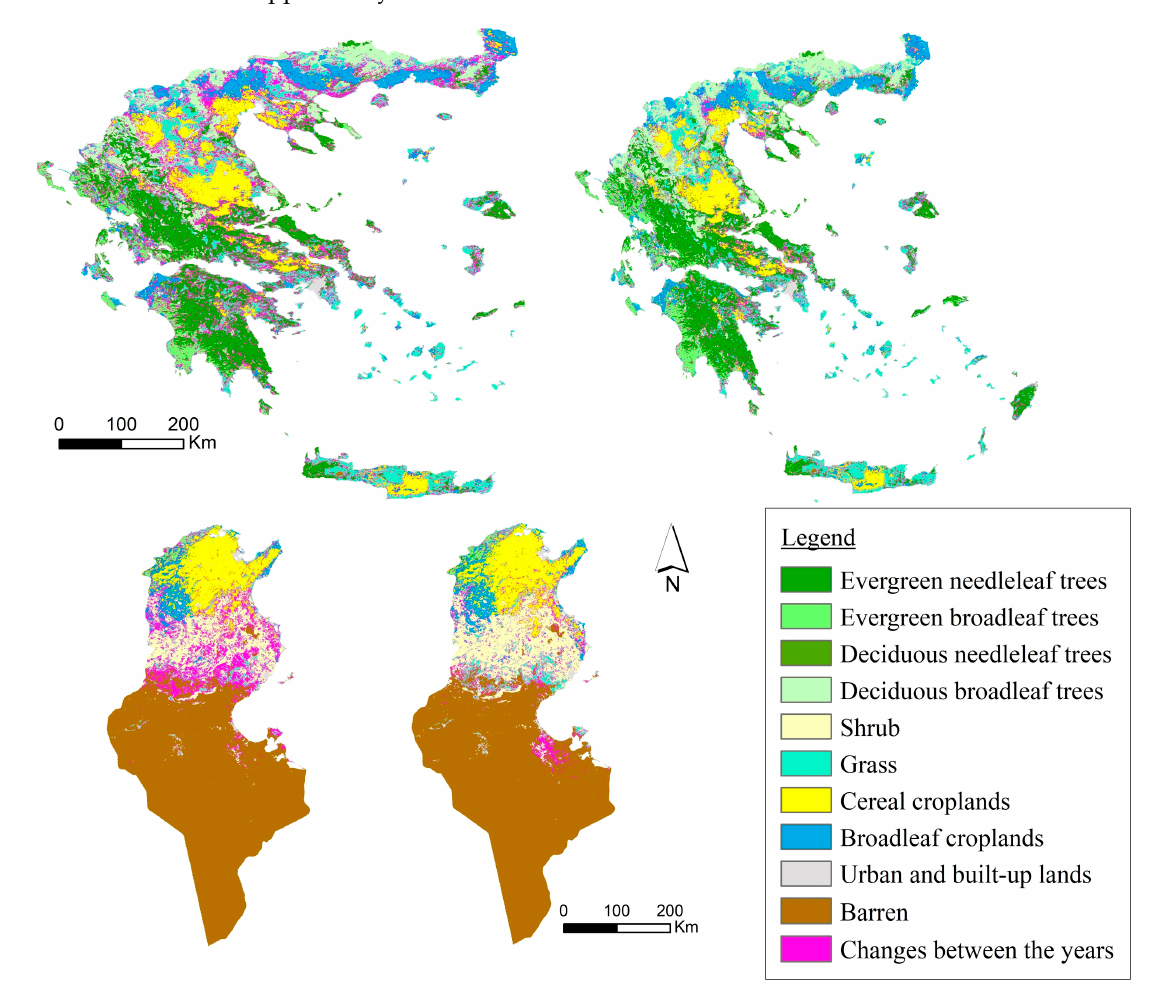
Figure 6. Distribution map of functional types of plants that have remained unchanged during the baseline period ( left : 2001–2015) and during the reporting period ( right : 2016–2020). In Greece ( top ) and in Tunisia ( bottom ).